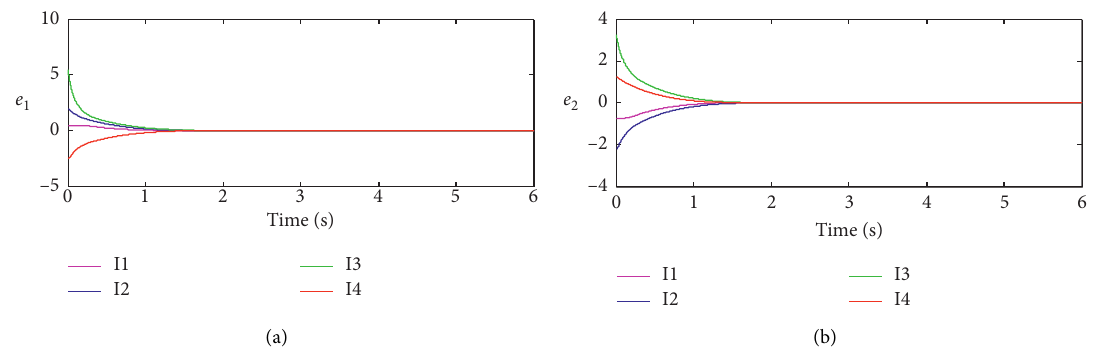
Figure 3: Position tracking errors with different initial states.